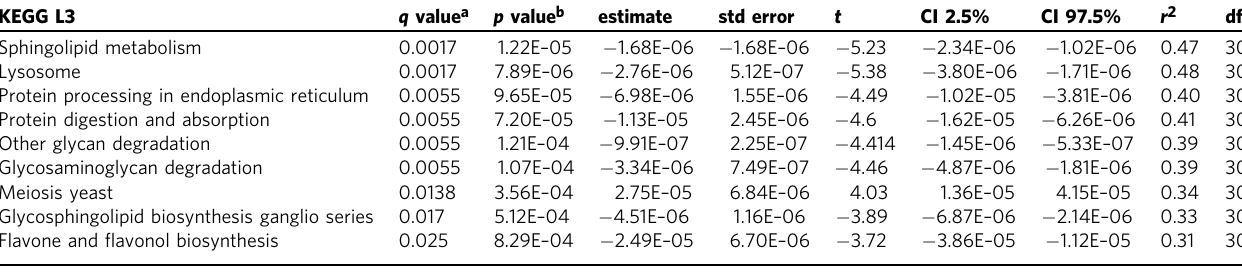
Table 2 Predicted metagenomic functional ability associated with 1-month Weighted Unifrac principal coordinate 1. KEGG